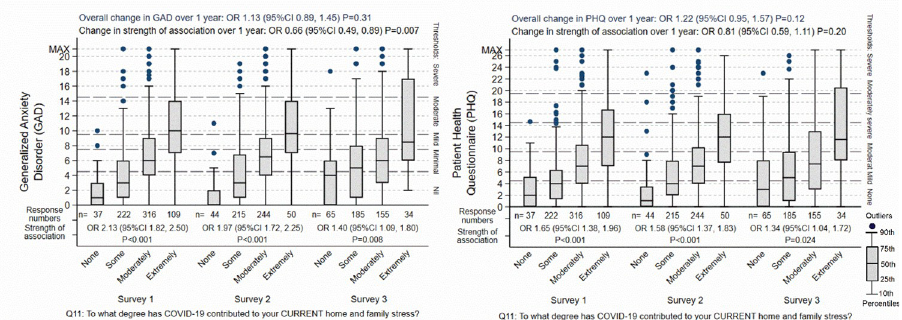
Fig 4. Effect of home / family stress on GAD-7 and PHQ-9. The “Overall change over 1 year” is the background outcome scale O.R. for change in the respondents not explained by the predictor variable included in the regression models. The “Change in strength of association” is the O.R. for the change of the association of the specific predictor shown in the graph over 1 year, adjusted for the other predictors in the regression models. The box-plots display the group score distributions without adjustment for other predictors. The number of specific responses to the questions are shown at each response and survey period. The “Strength of association” is the association of between the outcome and predictor at each survey